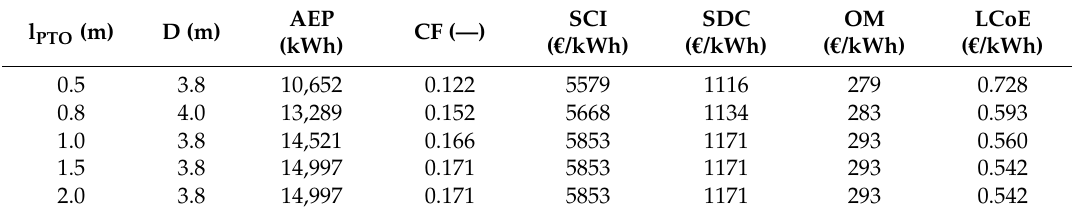
Table 8. Incidence of PTO free stroke length on main data of WEC devices without the fully submerged mass at